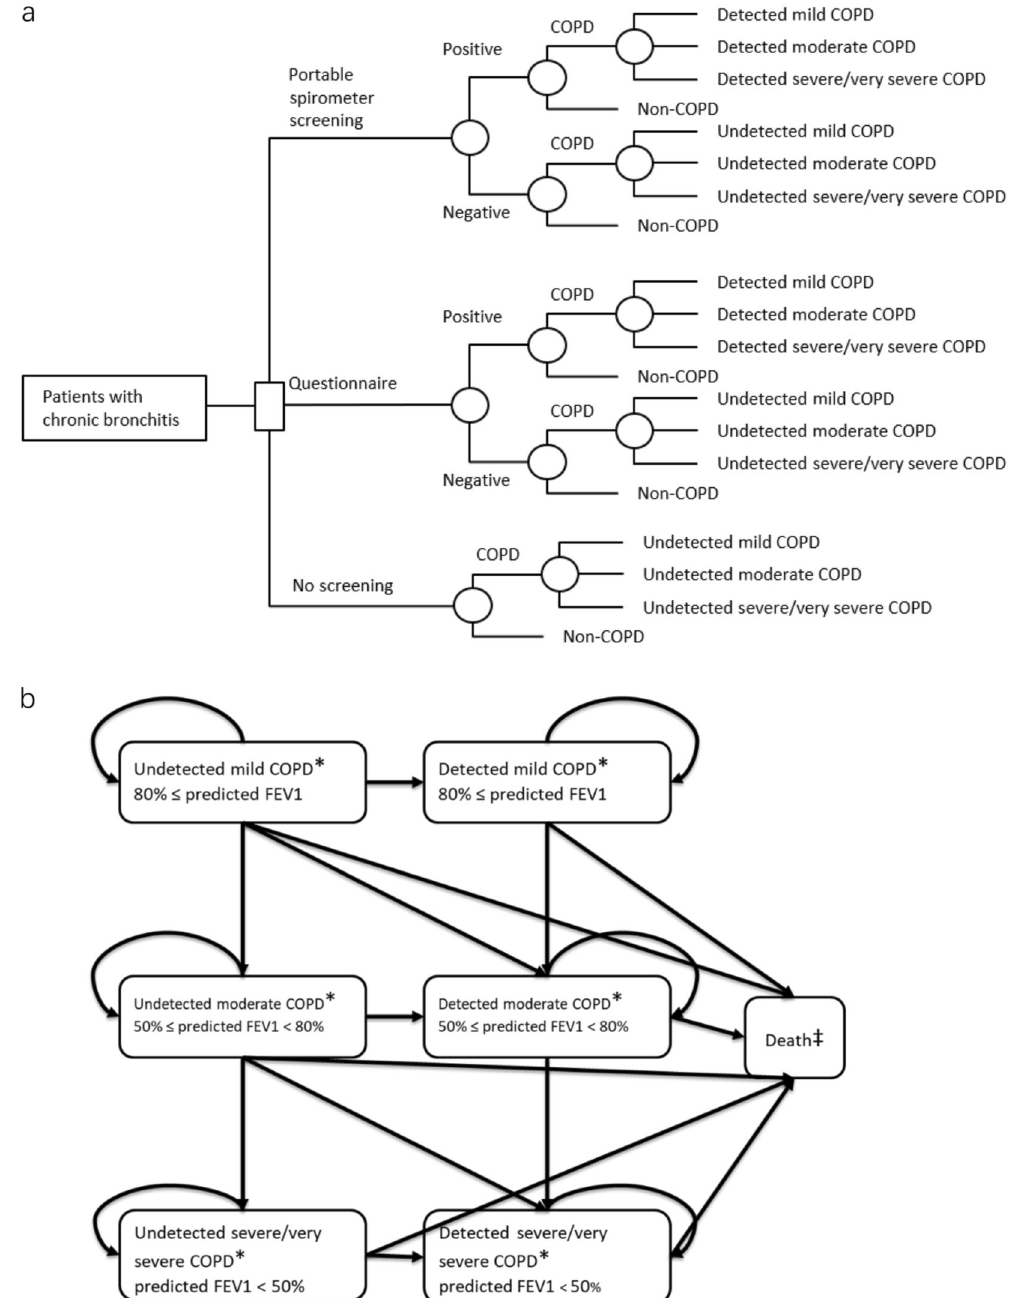
Fig. 4 Cost-effective model structure. Model structure: Decision tree (a), Markov model (b). *Within each health state, patients may experience either severe exacerbation, non-severe exacerbation or serious pneumonia. ‡ Death could occur following any health